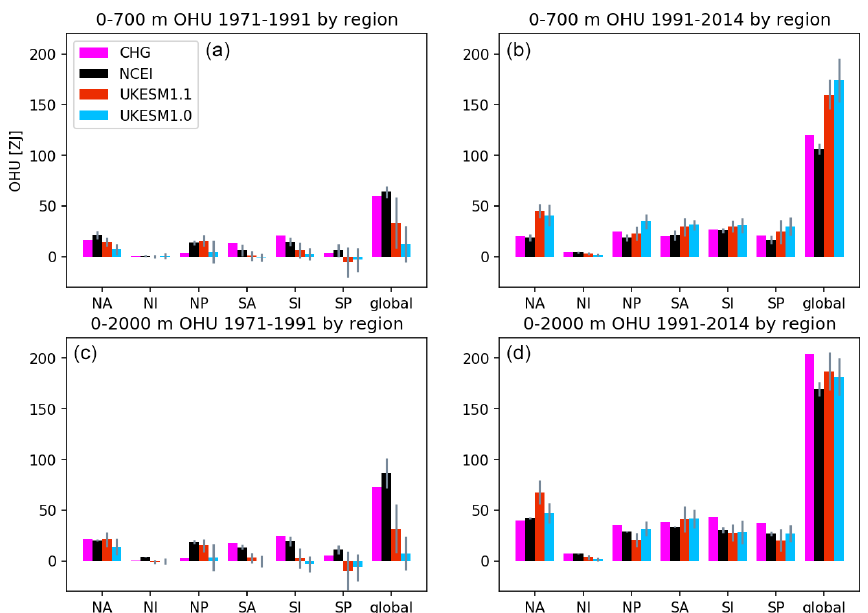
Figure 11. Ocean heat uptake (OHU) for six ocean basins and the global ocean in the 0–700m layer (a, b) and the 0–2000m layer (c, d) for the 1971–1991 period (a, c) and the 1991–2014 period (b, d) . Colour code as in Fig. 10. Thin grey bars give the standard error in the observational datasets and the ensemble standard deviation for the model ensembles. The ocean basins included are the North and South Atlantic (NA and SA) oceans, North and South Indian (NI and SI) oceans, North and South Pacific (NP and SP)